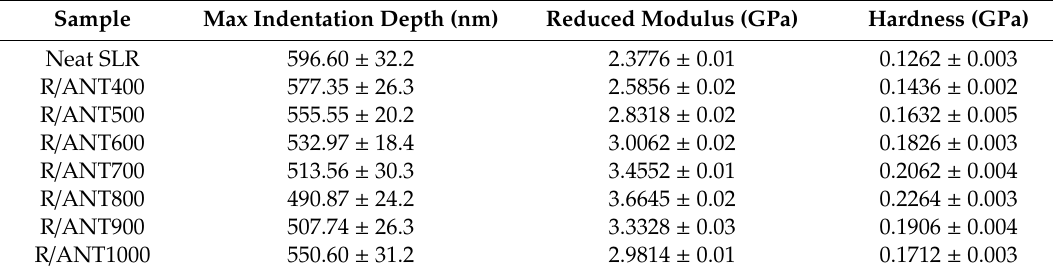
Figure 8. ( a ) Indentation load-depth curves for 3D printed samples of neat SLR and SLR/nanofillers composites. ( b ) The reduced modulus and hardness of 3D printed samples of SLR and SLR/nanofillers composites. Table 2. Results of 3D printed samples of pure SLR and SLR / nanofillers nanocomposites from the nanoindentation test.